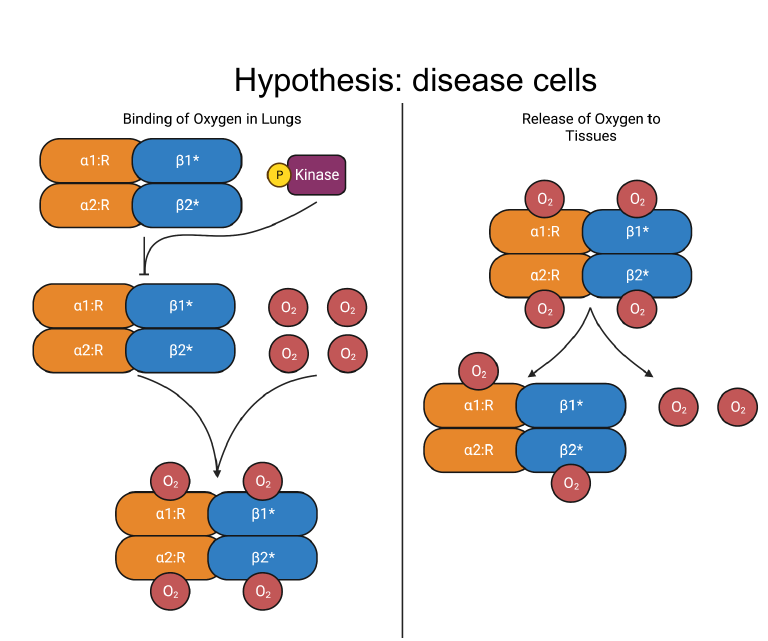
Figure 6. Diagram of oxygen binding to hemoglobin and subsequent release to tissues. ( A ) In the lungs, oxygen binds to hemoglobin, which is composed of two αβ heterodimers [107–109]. Y145 on the β chains is phosphorylated [31]. Interdimeric bonds that stabilize the T state are broken as oxygen binds, and the molecule transitions to the R state, increasing oxygen affinity [109,110]. In the tissues, oxygen is released, and hemoglobin reverts to the T state. ( B ) Mutations of Y145 (such as Y145H, Y145C, and Y145N, indicated by “ β 1*” and “ β 2*”) disrupt interdimeric bonds and phosphorylation, favoring the R state over the T state and increasing oxygen affinity [104,111–117]. The consequent increase in oxygen affinity diminishes the release of oxygen to the tissues and provokes compensatory erythrocytosis [102,104].